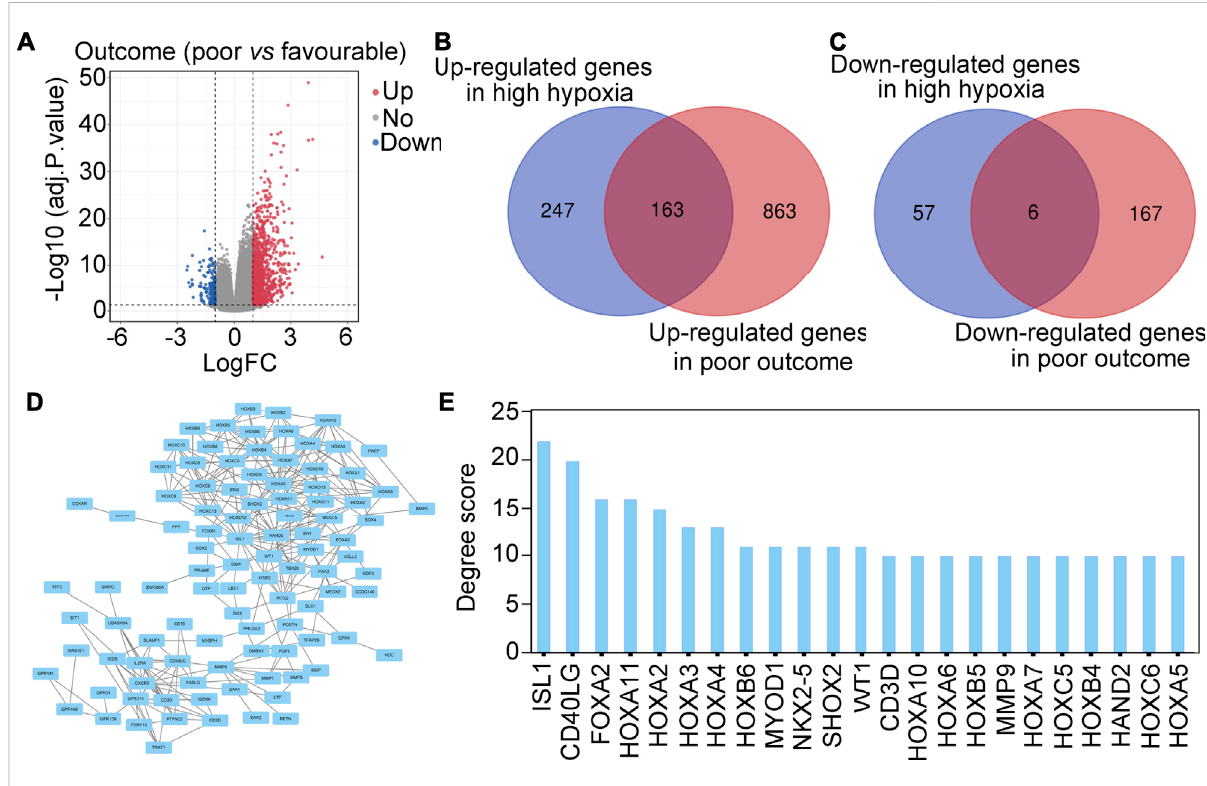
FIGURE 2 Screening important hypoxia-driven genesassociated with poor outcome inglioma tis-sues. (A) Volcano plotindicating DEGs between glioma patients with poor (progressive disease, PD) or favorable (complete response, CR + partial response, PR + stable disease, SD) outcomes. (B) Intersection analysis demonstrated that 163 genes were up-regulated in gliomas with high-hypoxia and poor outcome. (C) Intersection analysis demonstrated that 6 genes were down-regulated in gliomas with high hypoxia and poor outcome. (D) PPI network of 169 important hypoxia driven genes associated with outcome in glioma. (E) Degree score of genes in the PPI network ≥